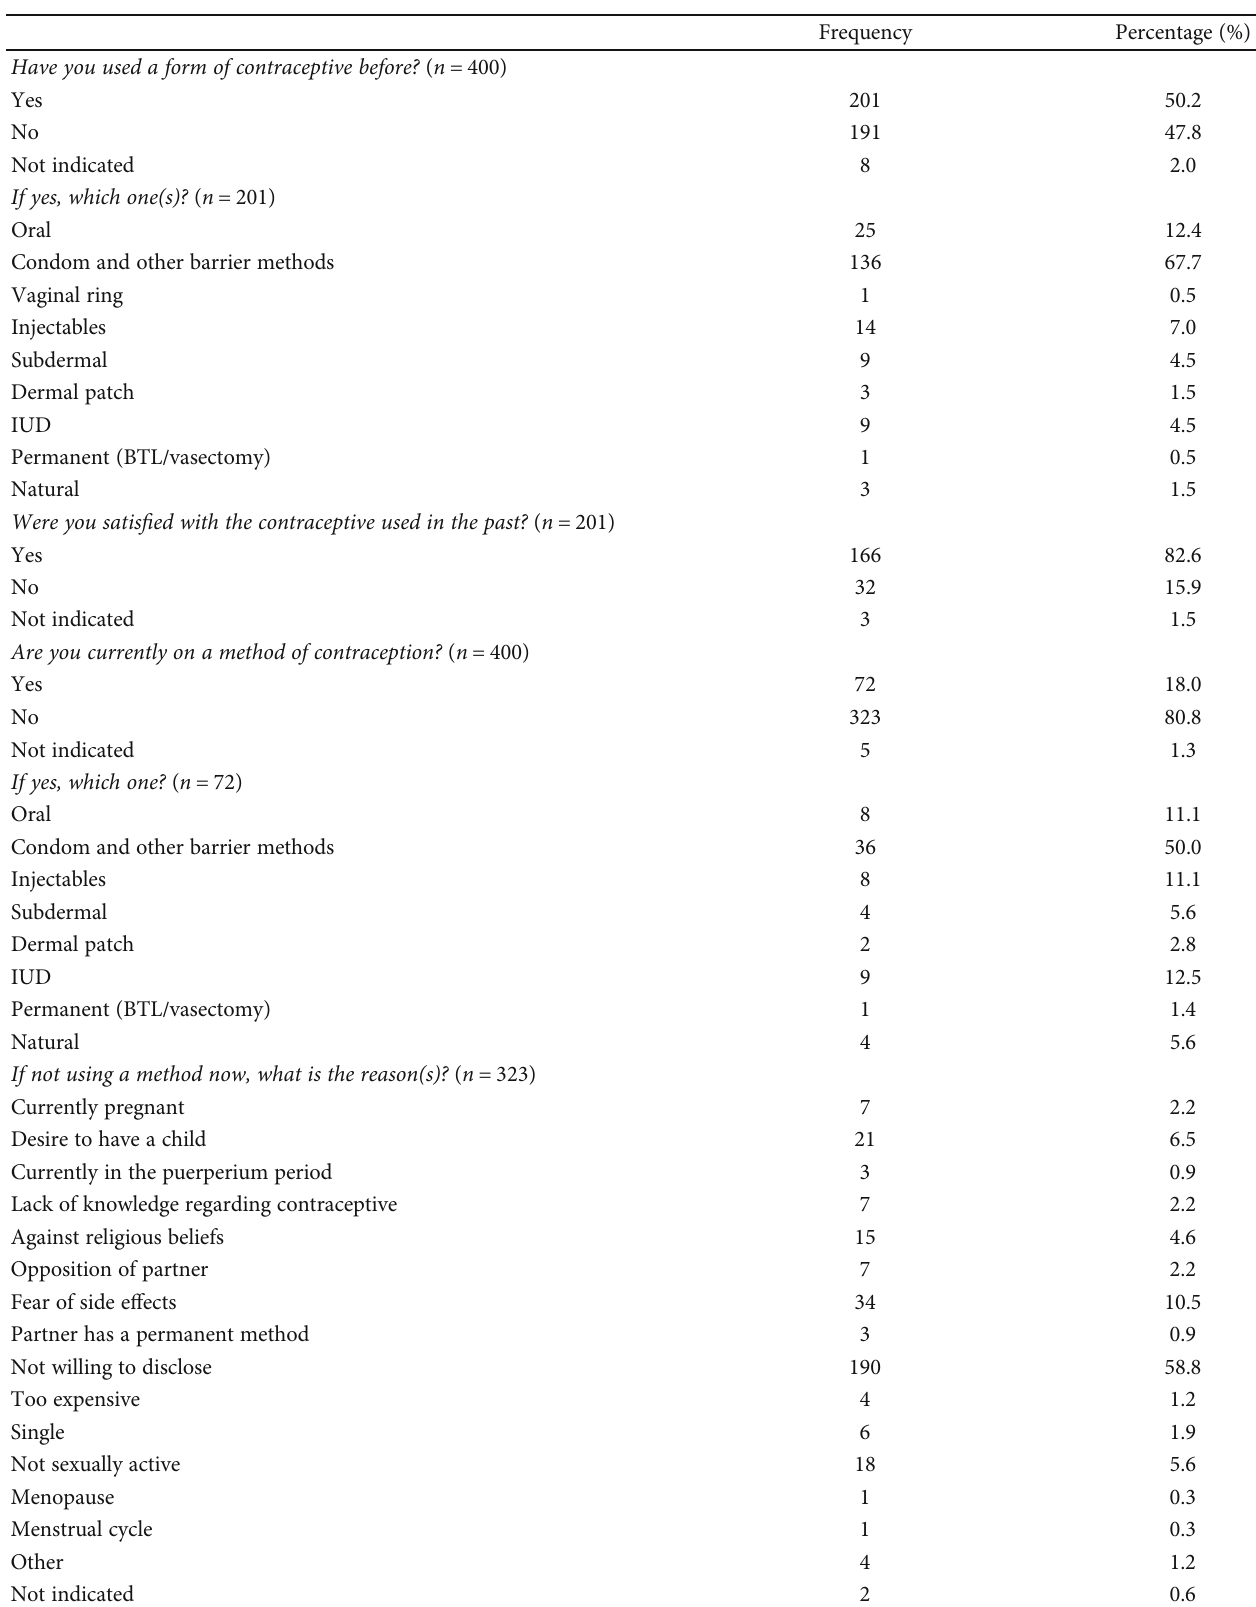
Table 3: Contraceptive practices among study